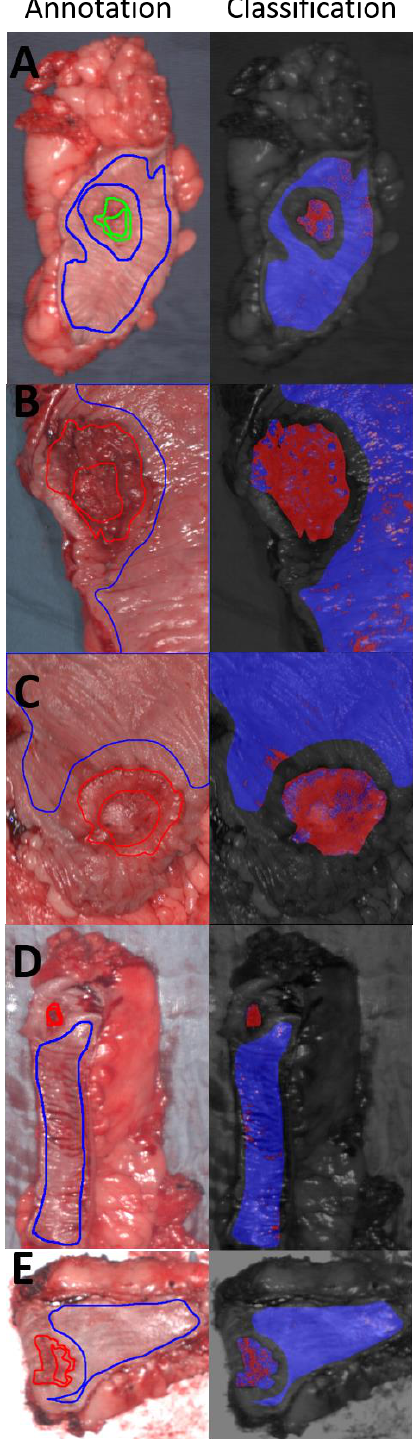
Figure 3. ( A , C , E , G ) represent annotation and classification of cancerous tissue: A = adenoma; B = ypT2 pN1a (1/23) pM1a (PUL) L1 V0 Pn0, UICC Stage IV A; C = pT2 pN0 (0/18) M0 L0 V0 Pn0, UICC Stage yp III A. (red fill: cancer and adenoma, red line: cancer, green line: adenoma, blue fill: healthy mucosa, blue line: healthy